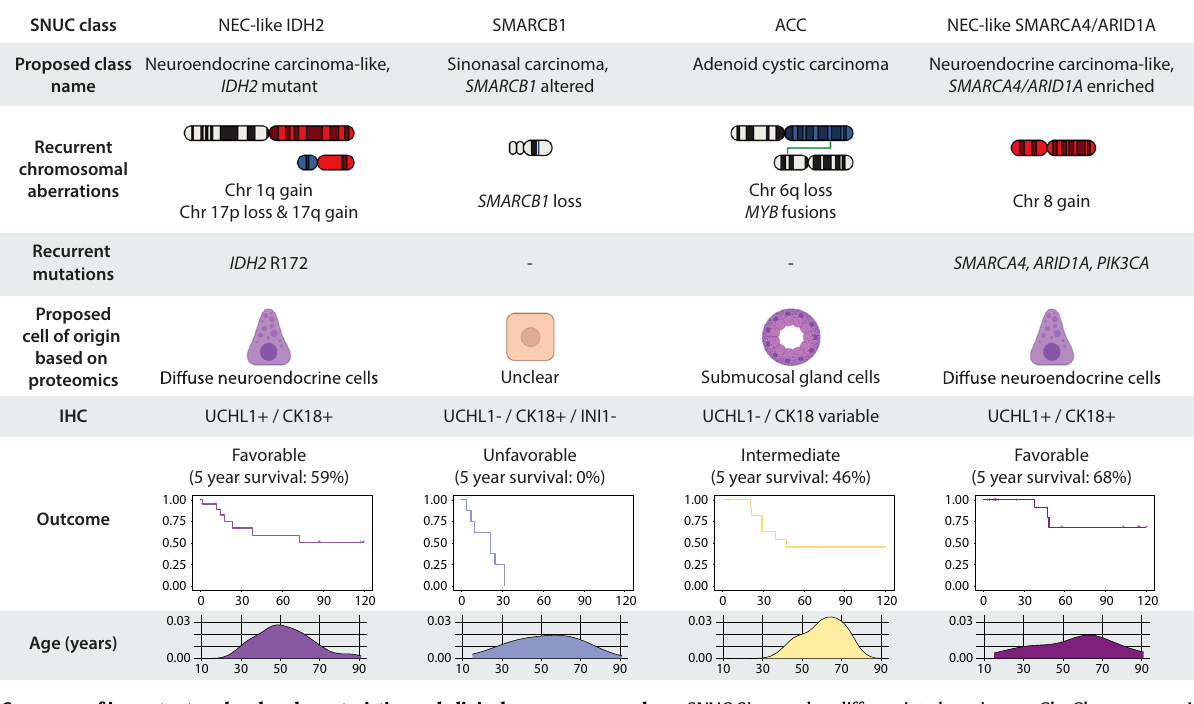
Fig. 6 | Summary of important molecular characteristics and clinical para- meters of the four sinonasal undifferentiated carcinoma (SNUC) classes, including proposed type names and potential immunohistochemical (IHC)